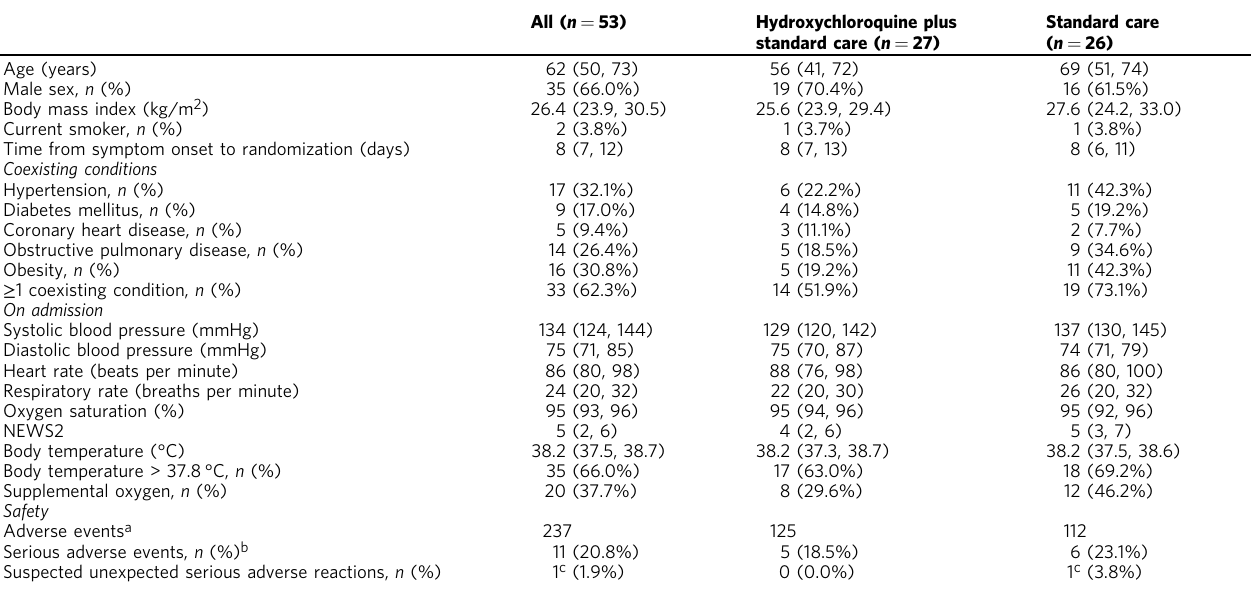
Table 1 Demographics, baseline characteristics, and safety during the trial.